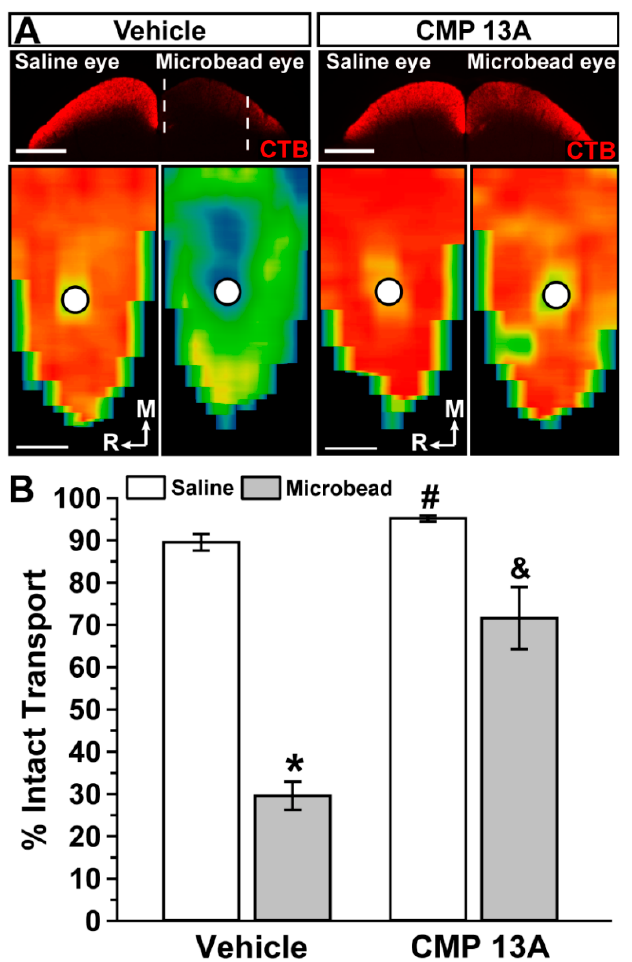
Figure 2. Collagen mimetic peptide protects anterograde axon transport. ( A ). Single sections through superior colliculus (top) showing regions of intact CTB transport (red) for mice receiving either vehicle (n = 6) or CMP 13A (n = 7) via intravitreal injection. In vehicle mice, the colliculus serving the optic projection from the saline-injected eye had fully intact transport, while microbead-induced IOP elevation in the fellow eye created regions of degraded transport (dashed lines). Retinotopic maps (bottom) reconstructed from serial sections through colliculus show levels of intact CTB signal ranging from 0% (blue) to 50% (green) to 100% (red). Medial (M) and rostral (R) orientations are indicated, as is the representation of the optic disc (white circles). Scale = 500 µm. ( B ). For vehicle-treated mice, intact transport declined by 67% with microbead-induced elevations in IOP compared to colliculus from the saline eye (*, p < 0.0001), while microbead eyes from the CMP 13A cohort demonstrated a two-fold improvement in transport compared to vehicle microbead (&, p = 0.002) and did not differ significantly from intact transport in the vehicle saline eye ( p = 0.06). Interestingly, transport from the saline eye in the CMP 13A cohort exceeded that from the saline eye in the vehicle cohort (#, p = 0.01). Data = mean ± SEM.